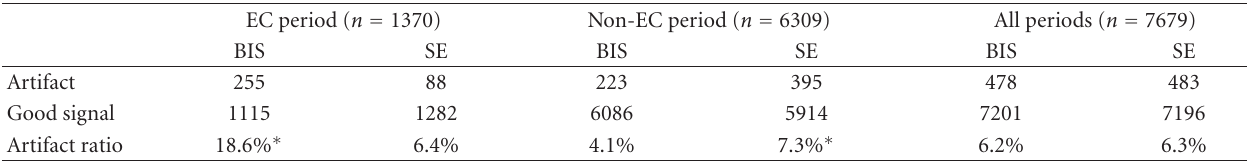
Figure 1: Bispectral index (BIS) and state entropy (SE) data with (top diagram) or without (bottom diagram) electrocautery (EC) use. The central set in each diagram represents data with artifact, whereas remaining set areas show good signal. Table 1: Number of data points of SE and BIS with artifact or good